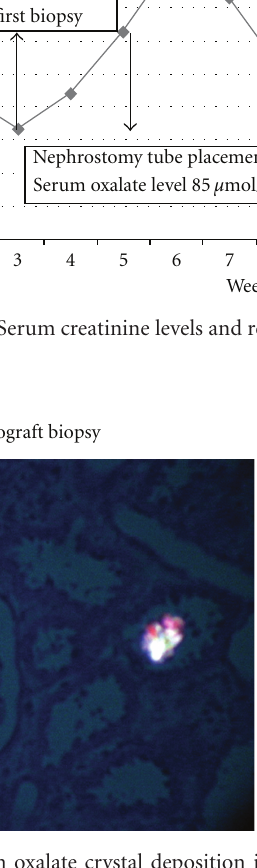
Figure 2: Biopsy Shows calcium oxalate crystal deposition in the renal tubules under polarized light microscopy (1st biopsy per- formed during 3rd week of